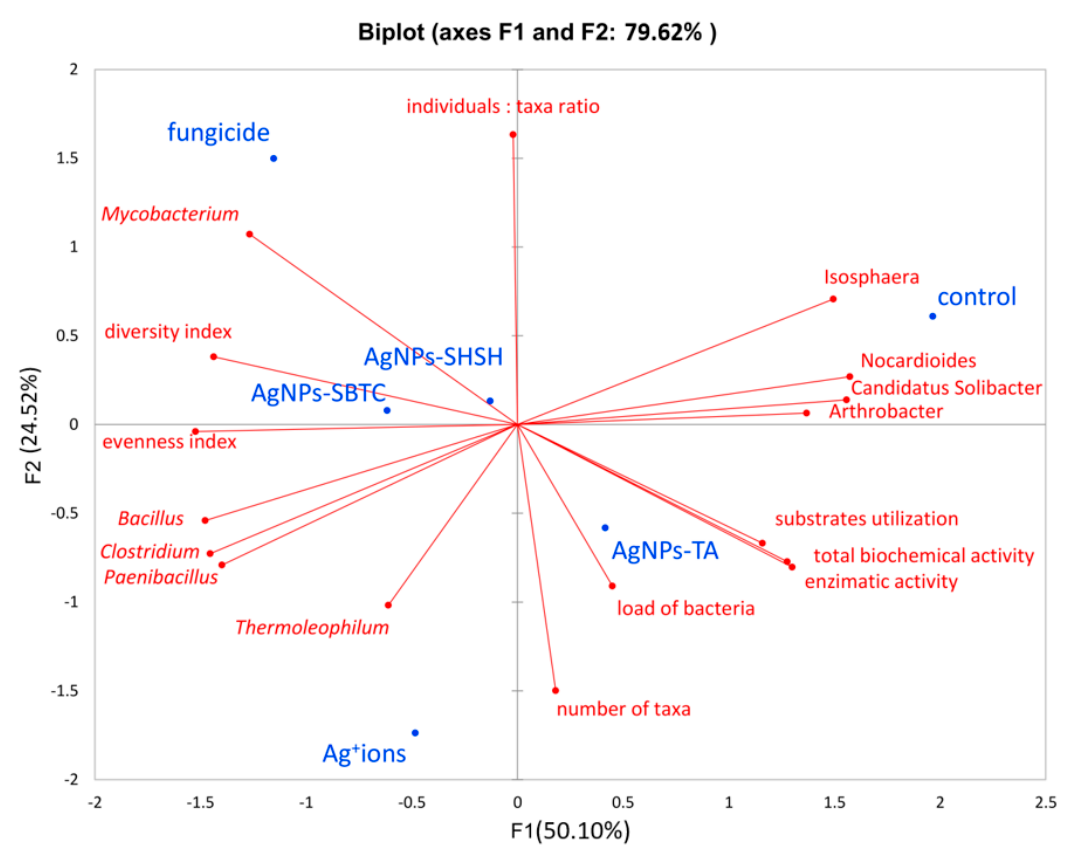
Figure 9. Principal Components Analysis based on alpha-diversity, biochemical and metataxonomic parameters.